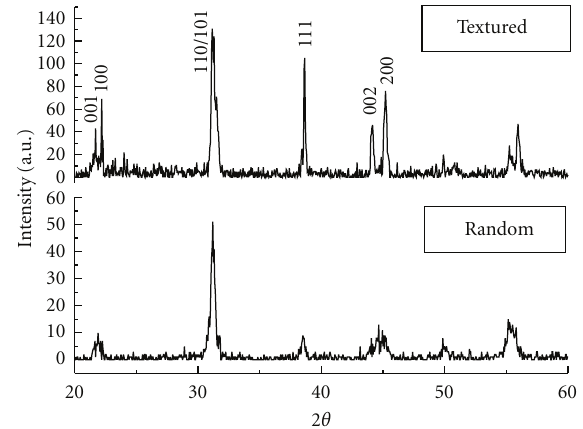
Figure 23: X–ray di ff raction pattern of textured PZT-PZN com- pared to randomly oriented PZT-PZN.